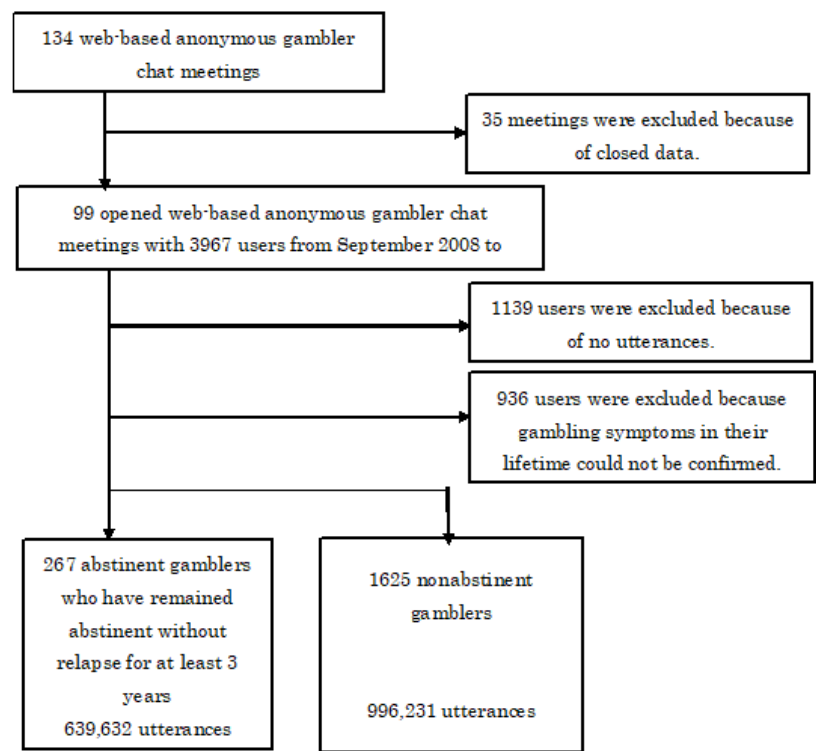
Figure 2. Data extraction of the